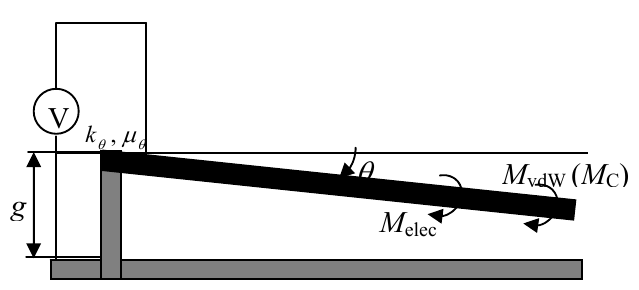
Figure 2. 1DLM for the torsional